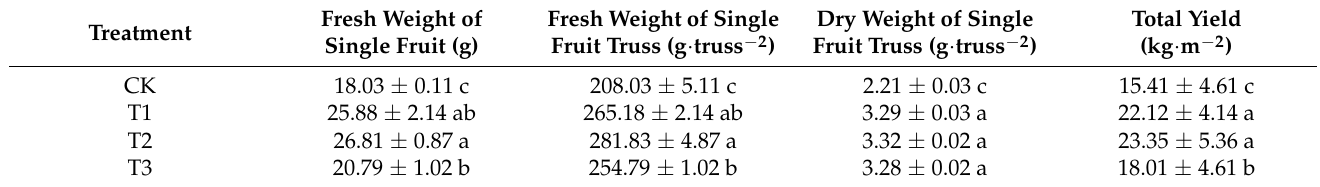
Table 2. Effects of different abaxial leafy supplemental lighting treatments on fruit yield of cherry tomato. Fresh Weight Treatment